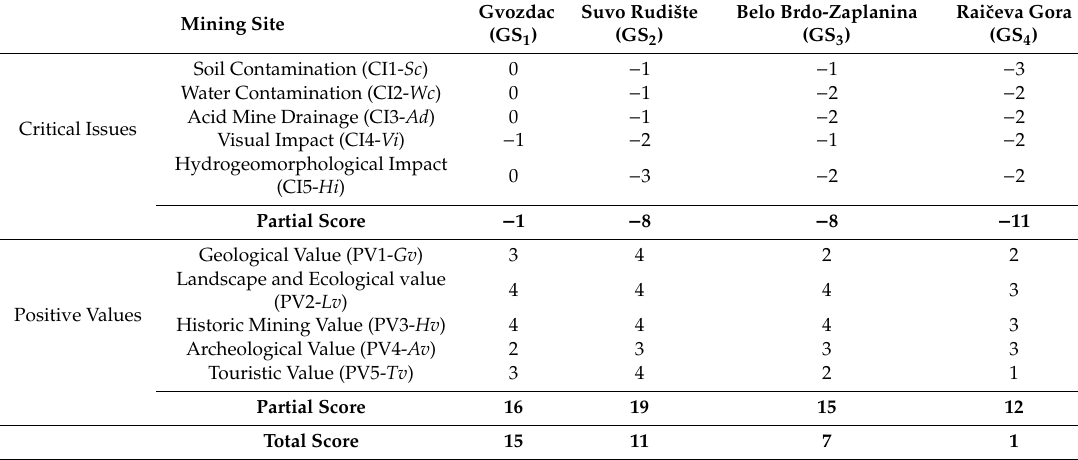
Table 5. Total scores for the four mines